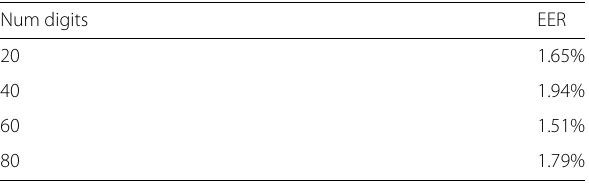
Table 4 One-shot-learning enrolment data results